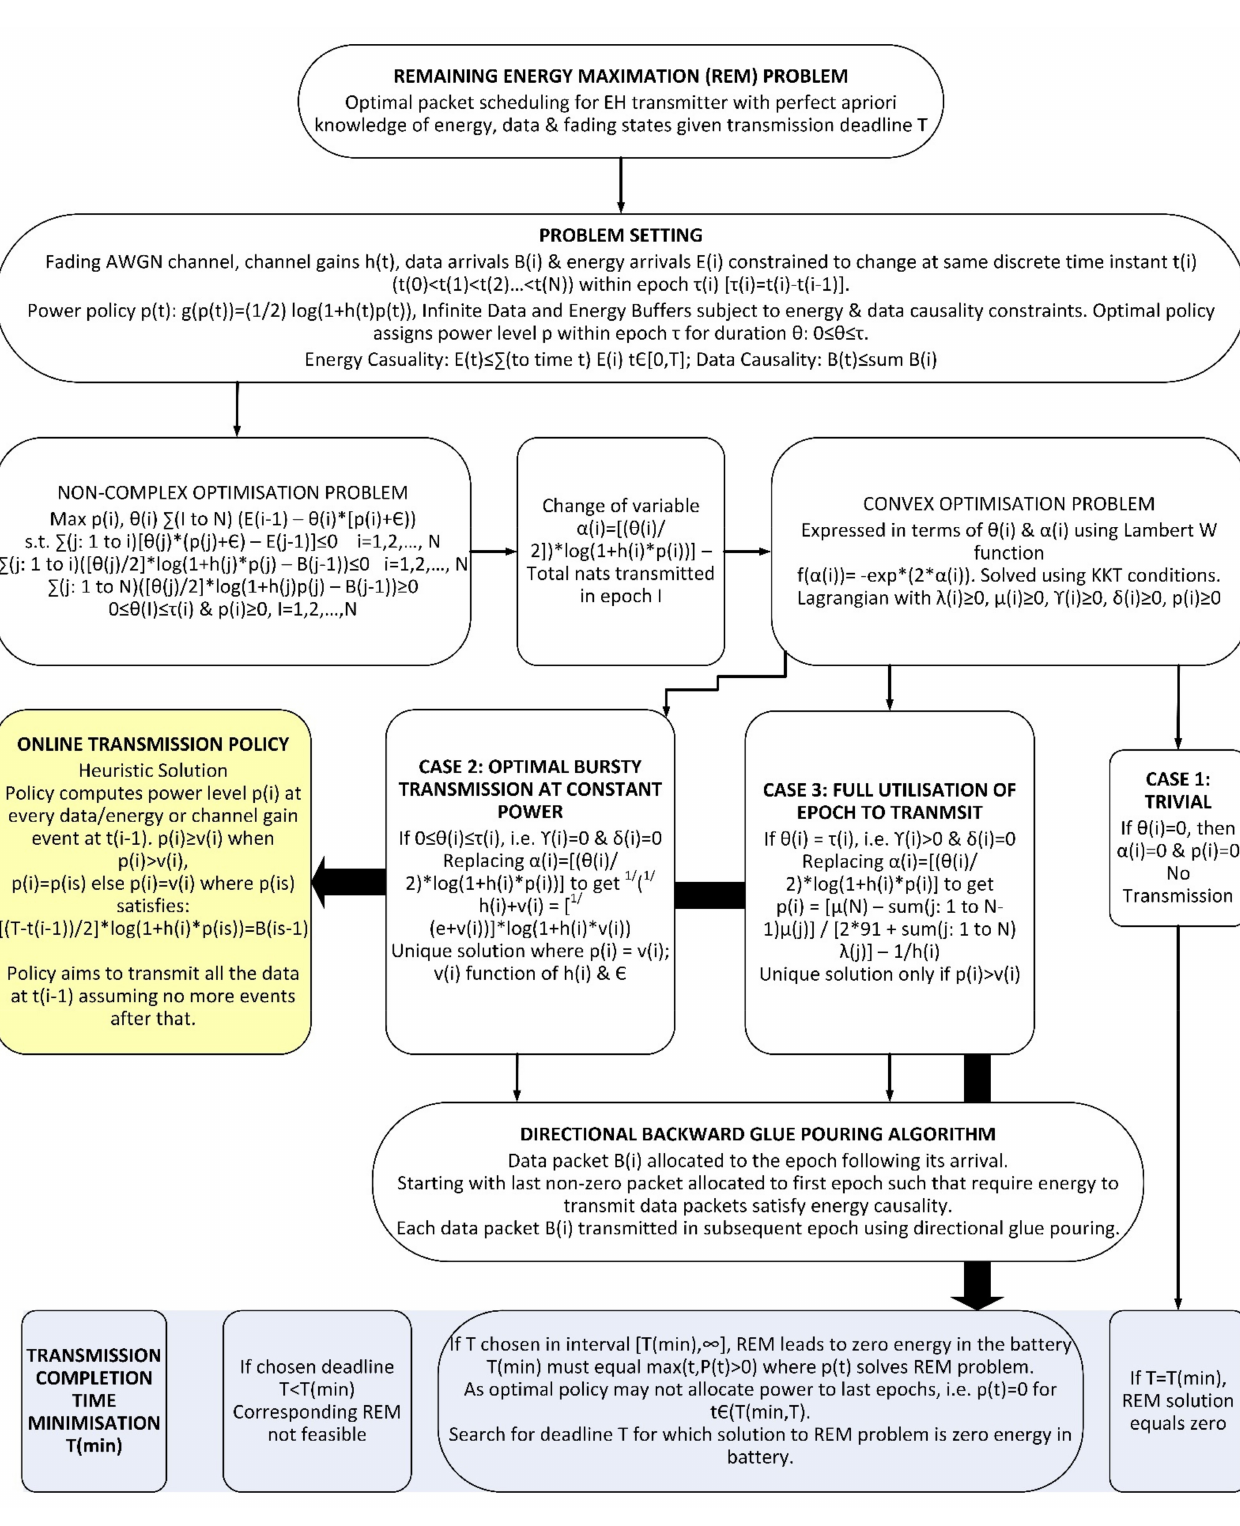
Figure 5. Directional glue pouring solution for energy